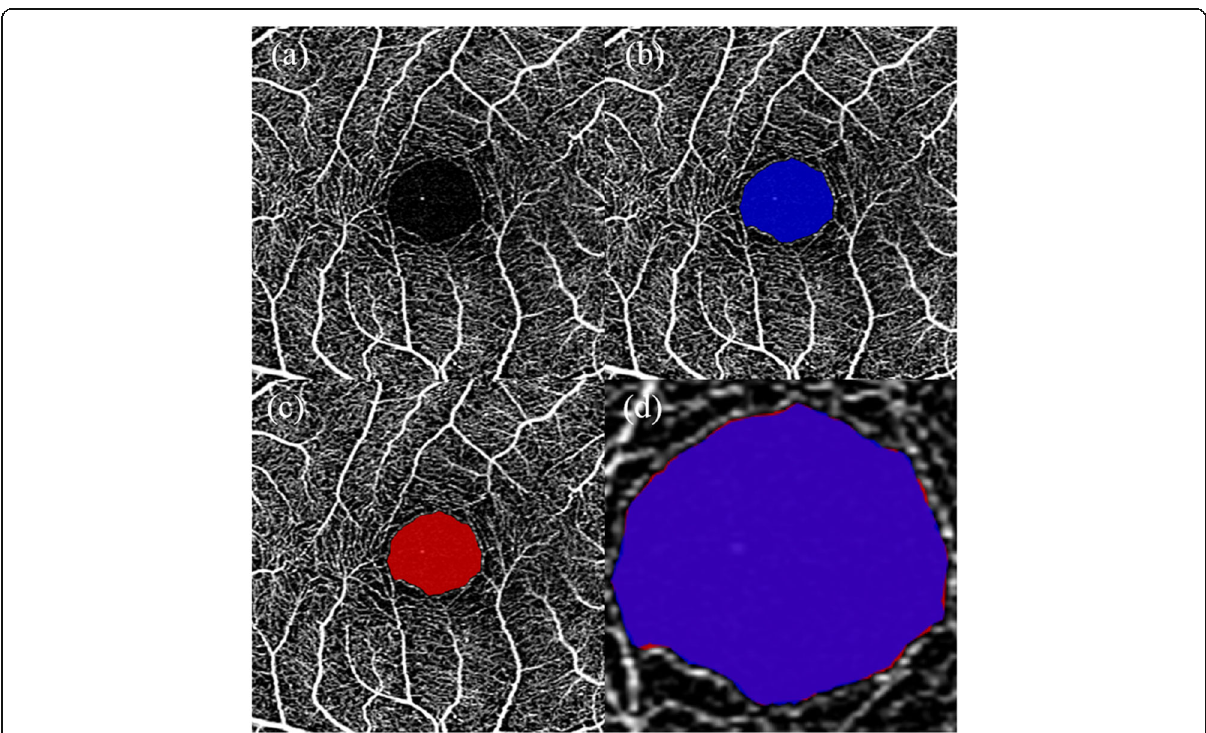
Fig. 5 A typical example of automatic superficial foveal avascular zone segmentation. The dice similarity coefficientwas 0.990. a Optical coherence tomography angiography (OCTA) image; b Automatic segmentation result (blue area) presented on OCTA image; c Ground truth (GT) (red area) presented on OCTA image; d Magnification of the differences between automatic segmentation results (blue area) and GT (red area); the purple area is the overlapping part of the automatic segmentation results and the GT